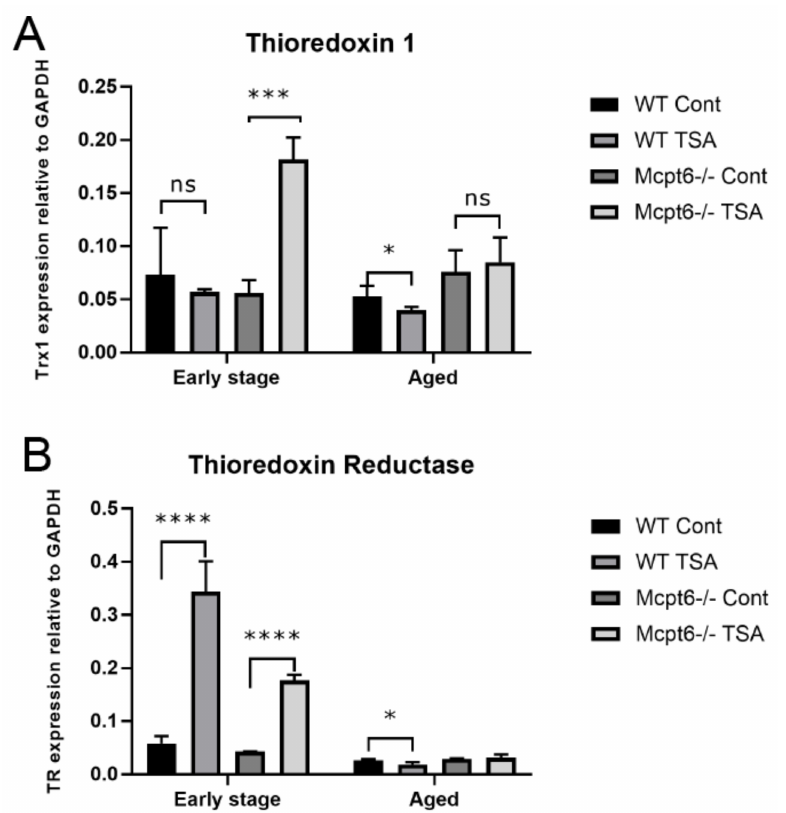
Figure 3. The absence of Mpt6 causes aberrant regulation of Thioredoxin 1 (Trx1) and Thioredoxin reductase (TR) in MCs exposed to TSA. WT and Mcpt6 − / − MCs (early stage and aged) were cultured